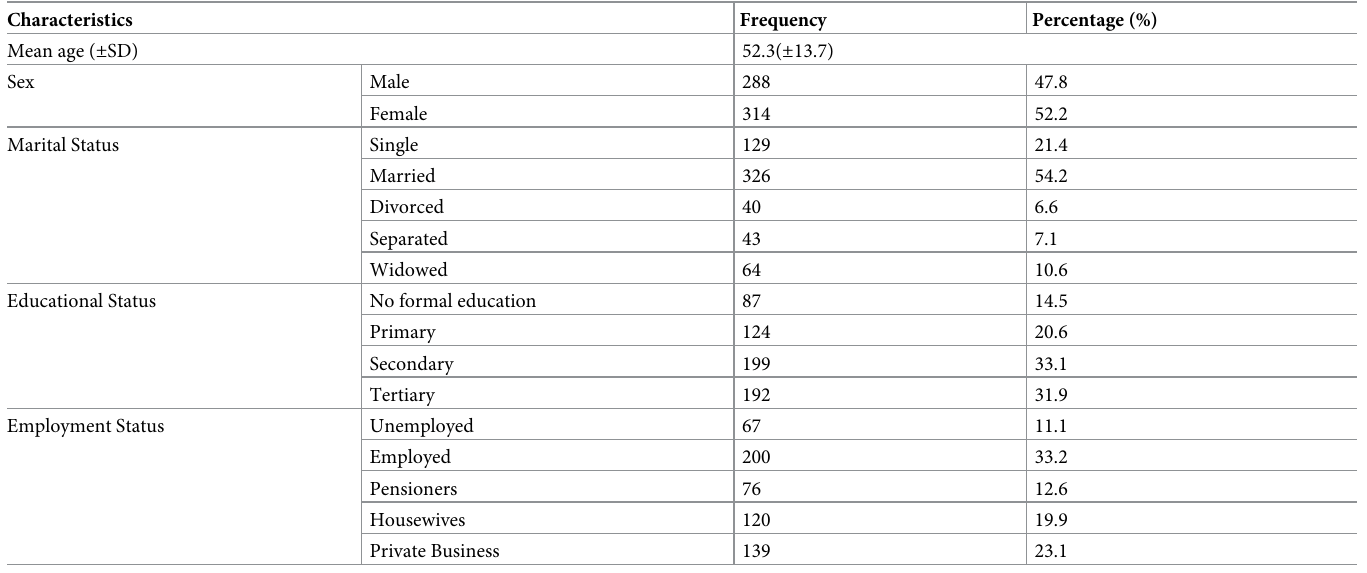
Table 1. Sociodemographic characteristics of patients with type 2 diabetes who had a regular medical check-up at selected public hospitals in Addis Ababa, 2019.